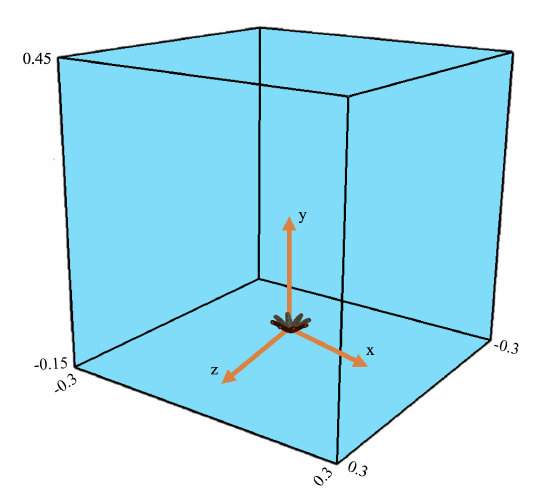
Fig. 4: The computational domain for a single coral polyp. Note that the boundaries in the x - and z -directions are periodic. The boundary conditions in the y -direction are no slip ( u = 0 at y = − 0 . 15 and y = 0 . 45 )